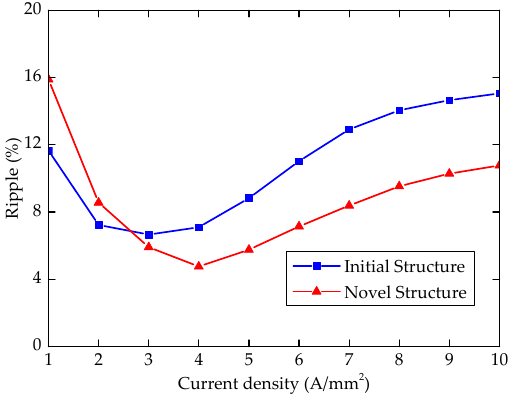
Figure 10. Torque ripple waveforms versus the current density.